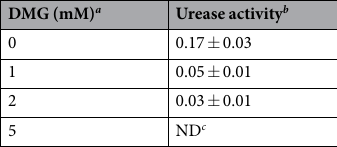
Table 2. Effect of DMG chelation on urease activity in K. pneumoniae BAA-2472. a DMG was added to LB broth, cells were grown overnight and urease assays were performed on cell-free extracts using the phenol- hypochlorite method of Weatherburn 55 . b Urease activity is expressed in μ moles of NH 3 produced per min per mg of total protein. c ND, not detected ( < 0.001) Values shown are the mean ± standard deviation for at least three independent biological replicates, with assays done in triplicate. Urease activities measured for all DMG- supplemented conditions are significantly lower compared to the no-DMG control ( P < 0.01, Student’s t